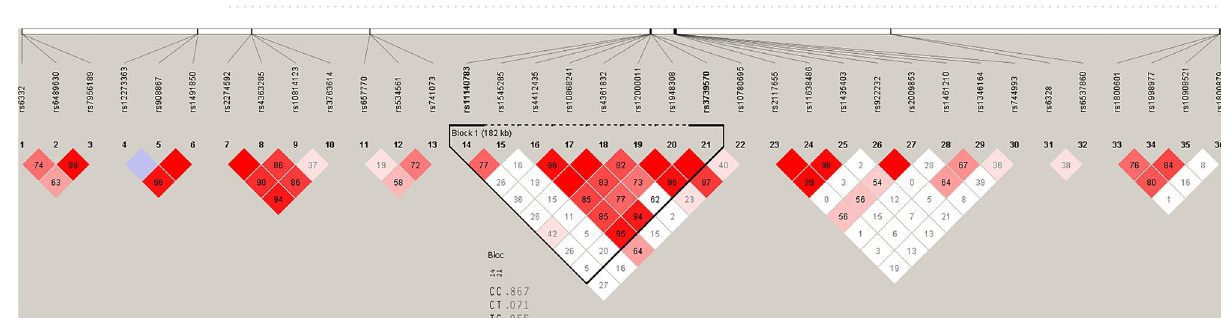
Figure 3. Haplotype block map. The upper part of the figure shows the haplotypes block map and the lower part contains the transition scheme of haplotypes. The lines in the transition image show the movement from one block to the next. The frequency corresponds to the thickness of the line (connections with thin lines if higher than 1% and with thick lines if higher than 10%), and the D ′ coefficient measures the degree of linkage disequilibrium (LD) between the blocks.